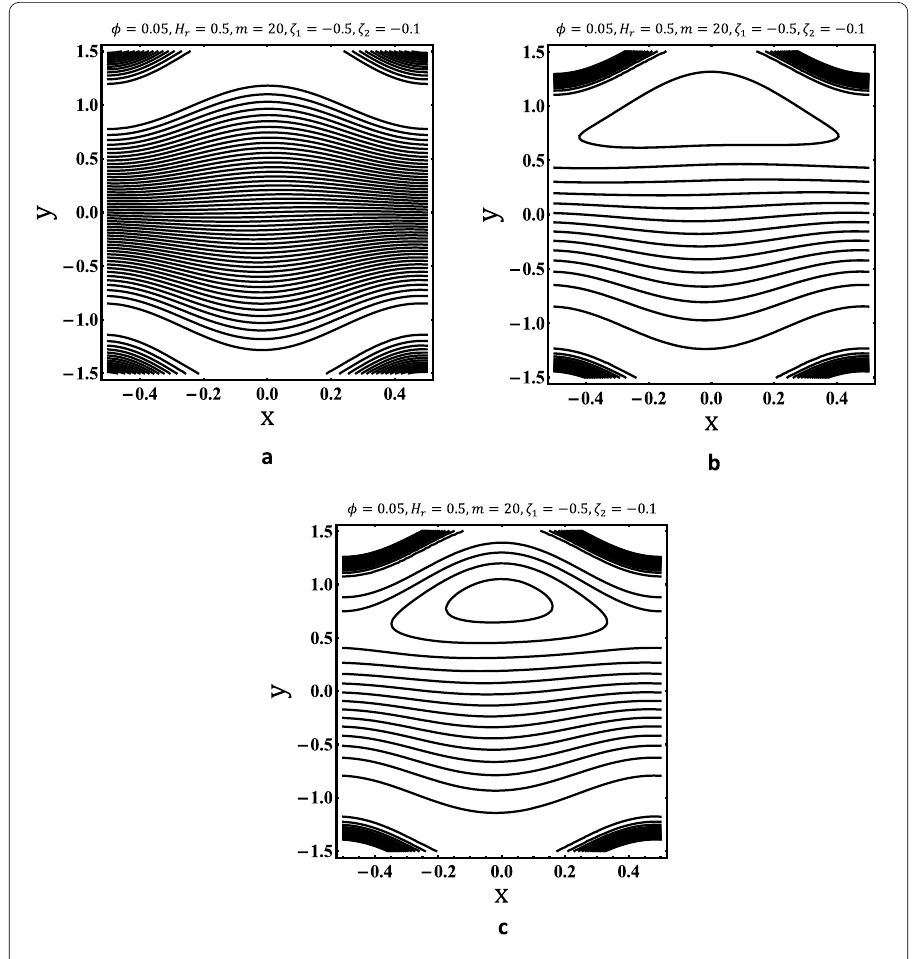
Figure 5 Streamline distribution for: ( a ) β = 0.0, ( b ) β = 0.5, and ( c ) β =